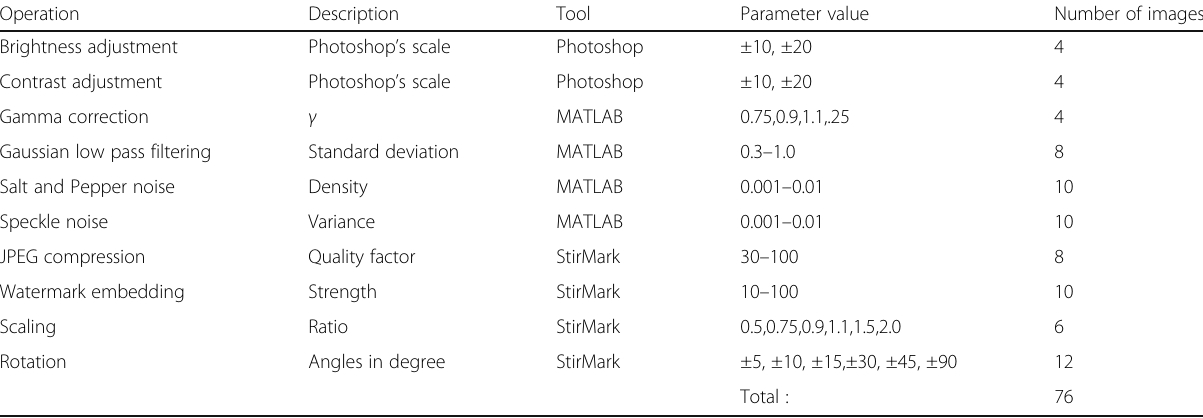
Table 2 The content-preserving activities on image